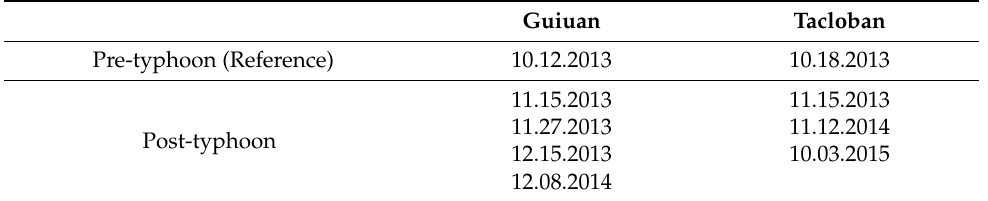
Table 1. The acquired date of satellite images used in this